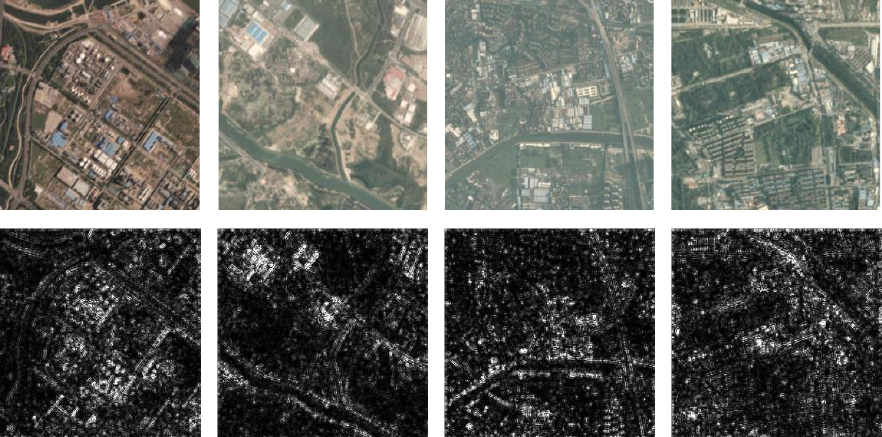
Figure 7. Gradient visualization with guided backpropagation of VGG-A. The first row shows the input satellite imagery samples and the second row shows the corresponding visualization results. Larger gradient values result in higher brightness in the